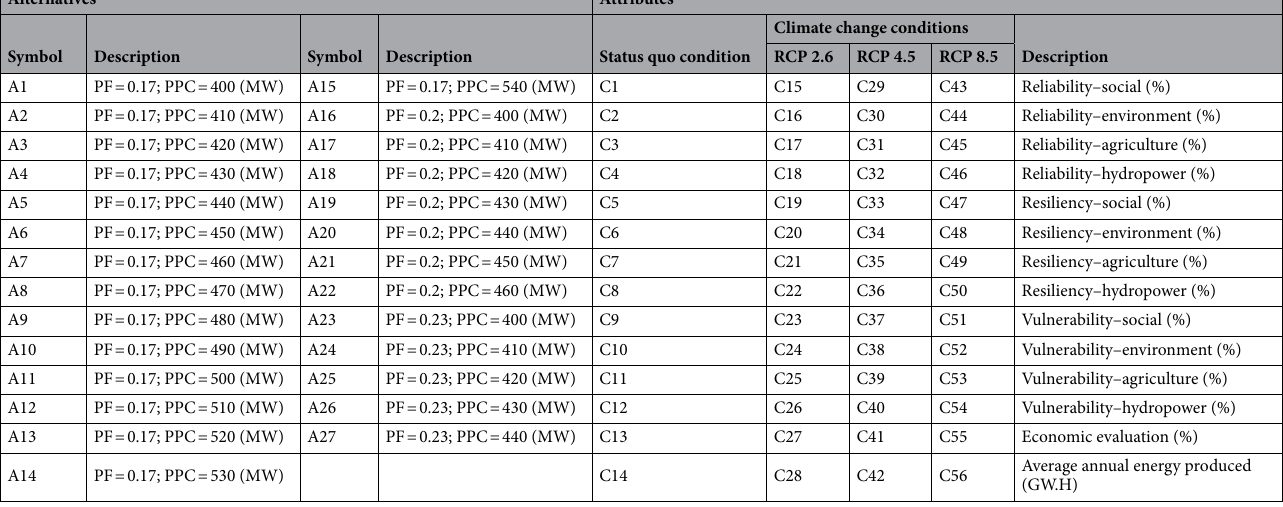
Table 2. Components of the MADM